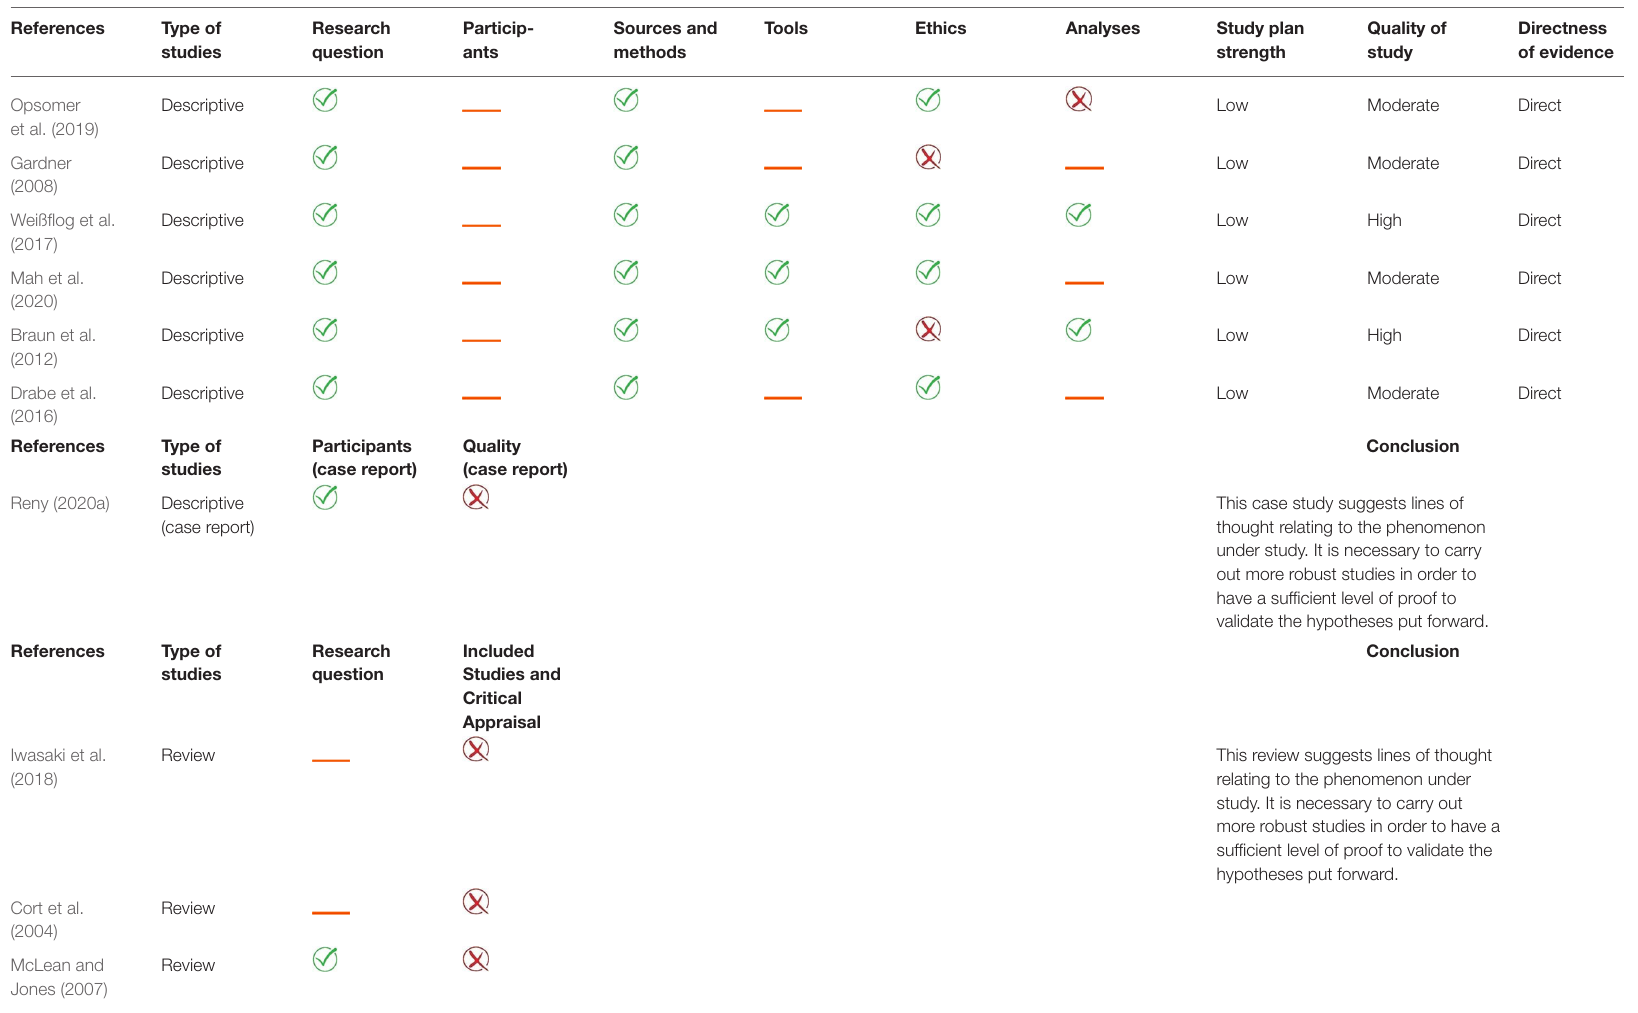
TABLE 2 | Quality assessment of the included studies of dyadic experiences of the patient and his/her life partner when confronted with advanced